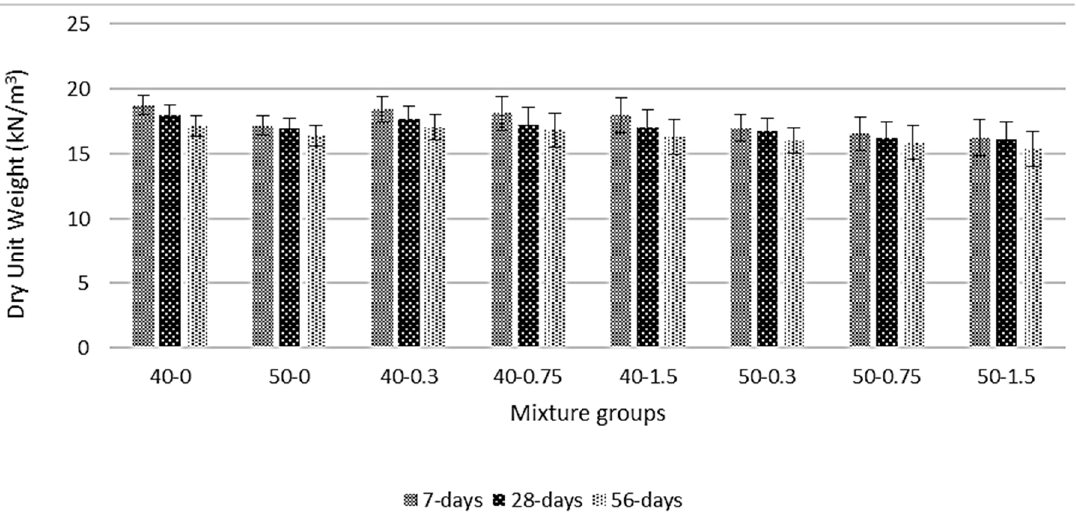
Figure 4. Dry unit weight for basalt-reinforced bottom ash cement paste composites at 7, 28 and 56 days of curing.